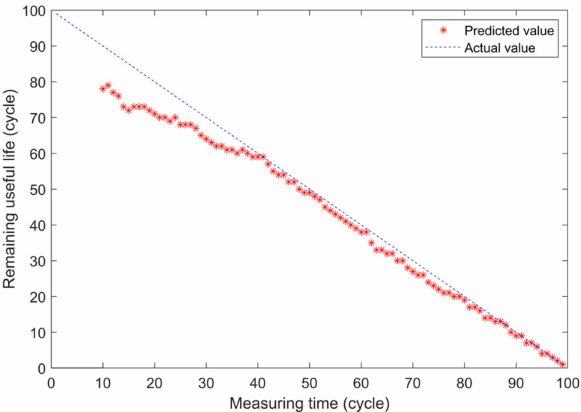
Figure 6. Predicted value and actual value of URL with simulation data.